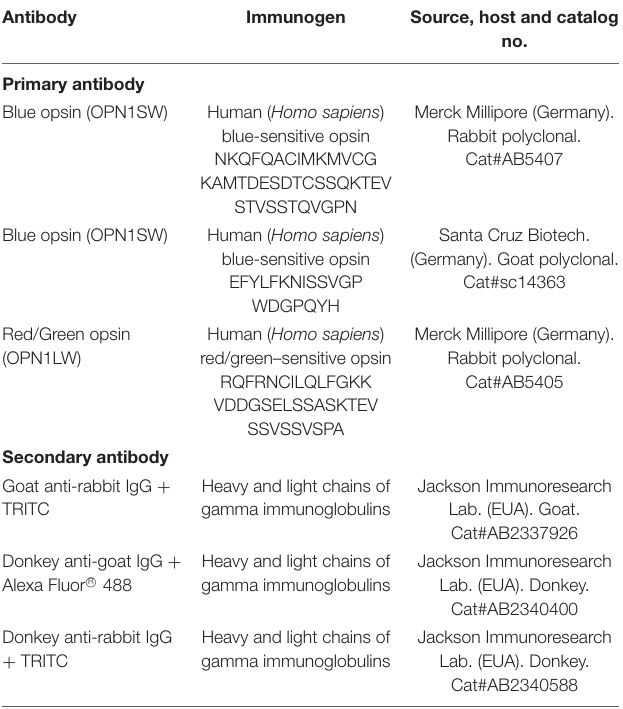
TABLE 1 | Primary and secondary antibodies used to label cones in retinas of snakes. Antibody